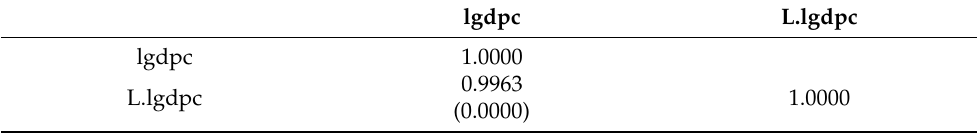
Table A2. Power correlation matrix. Author’s estimations.